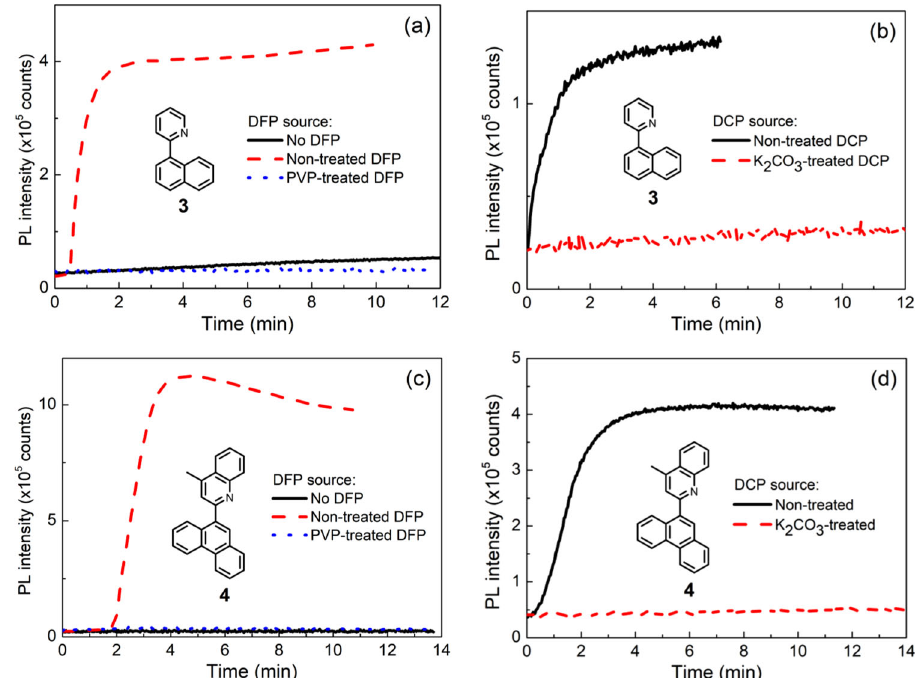
Fig. 10 Sensing results of compounds 3 and 4 upon exposure to differently treated DFP and DCP. Representative PL kinetics curves for ( a , b ) 10 wt% 3 : cellulose acetate sensing fi lms and ( c , d ) 10 wt% 4 :cellulose acetate sensing fi lms exposed to acid free and impure DFP and DCP sources. The